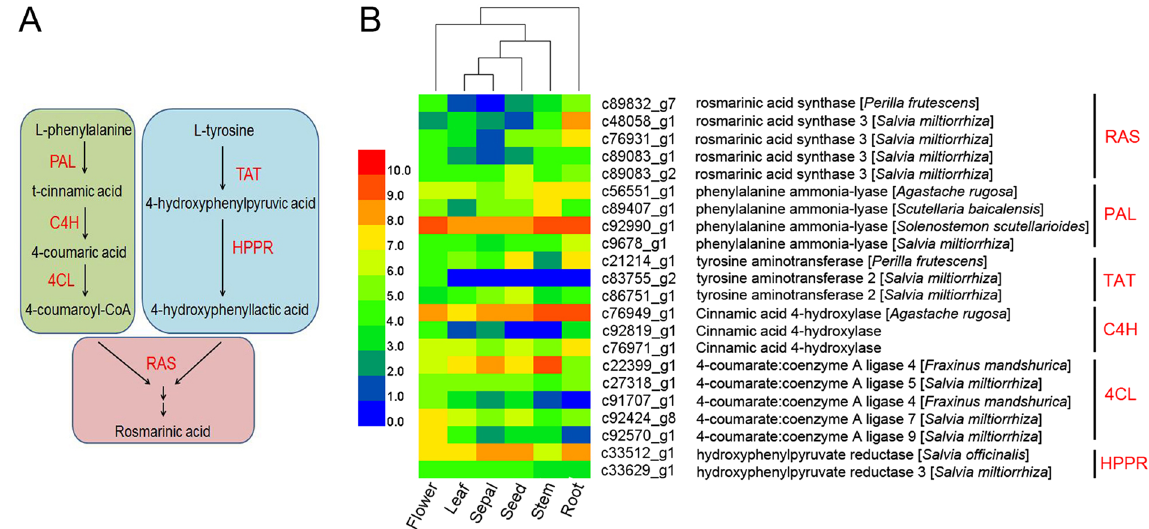
Figure 5. Hierarchical cluster analysis of expression profiles of 22 predicted biosynthetic genes related to RA in the six organs of Dracocephalum tanguticum . ( A ) Proposed biosynthetic pathway for RA. ( B ) Heat maps displaying the differential expression of transcripts encoding predicted biosynthetic genes related to RA. Expression values (FPKM) are log2-transformed and then median-centred by